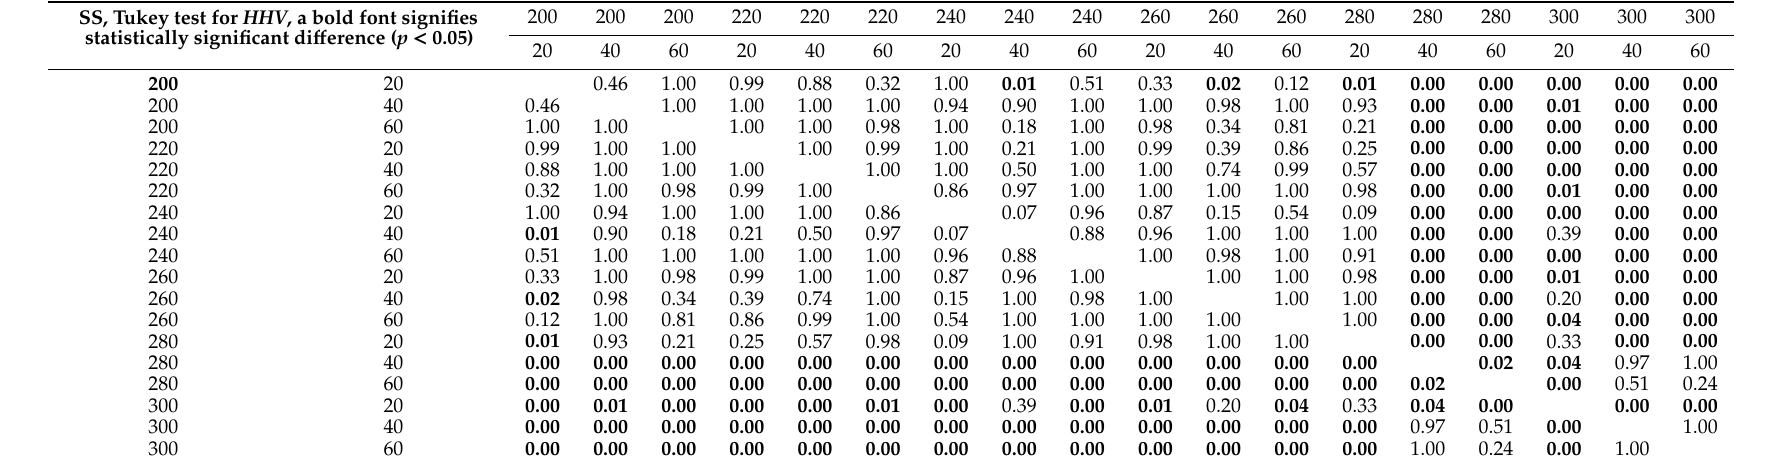
Table A14. Analysis of variance for HHV of sewage sludge.